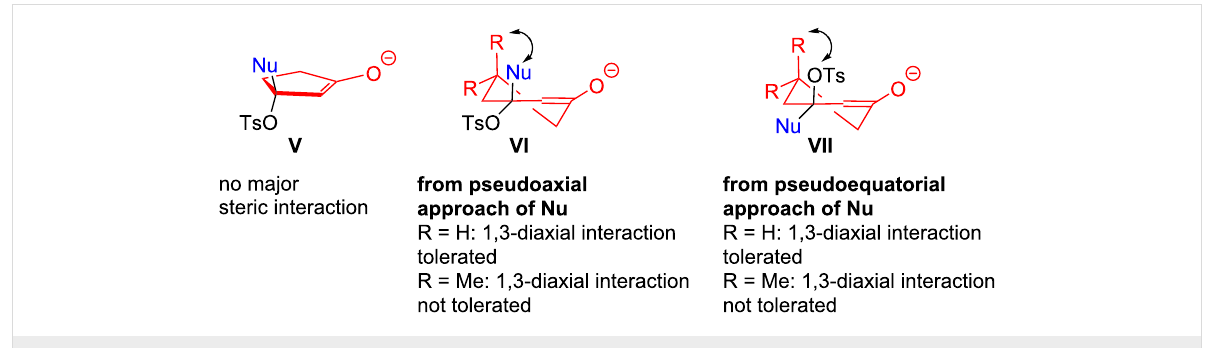
Figure 1: Nucleophilic addition to 5- and 6-membered cyclic